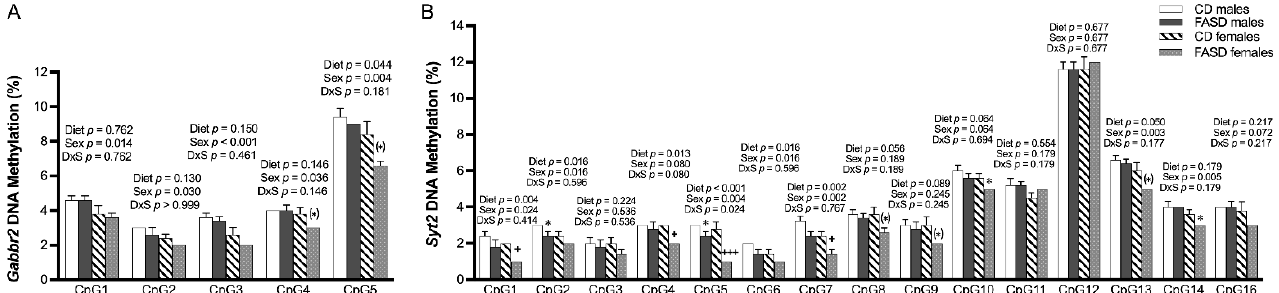
Figure 3. DNA methylation changes at CpGs in promoters of Gabbr2 and Syt2 in P30 pup cortices. ( A ) In the Gabbr2 promoter, there was a decrease in methylation at CpG 5 due to FASD, and a general decrease in methylation in all explored CpGs in females compared with males. ( B ) In the Syt2 promoter, there was a significant or a trend toward significant decrease in methylation at CpGs 1, 2, 4, 5, 6, 7, 8, 10, and 13 due to FASD, and a decrease or a trend for a decrease in methylation at CpGs 1, 2, 5, 6, 7, 10, 13, 14, and 16 in females compared with males. Valid data are not available for CpG15. Values are means ± SEM of 5 per group. p -Values from 2-factor ANOVA are indicated at the top of each CpG; Tukey post hoc p -values are indicated as + p < 0.05, +++ p < 0.001, and unpaired t -test values are indicated as * p < 0.05, ( * ) p = 0.065 ( Gabbr2 CpG 4), ( * ) p = 0.052 ( Gabbr2 CpG 5), ( * ) p = 0.066 ( Syt2